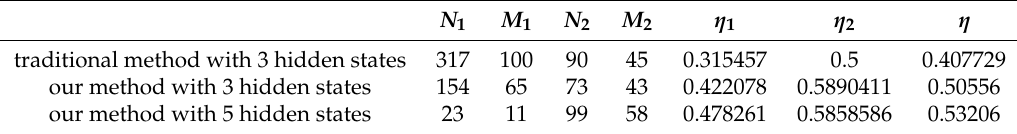
Table 3. Model accuracy after increasing the requirements for determining the status of bull. N 1 M 1 N